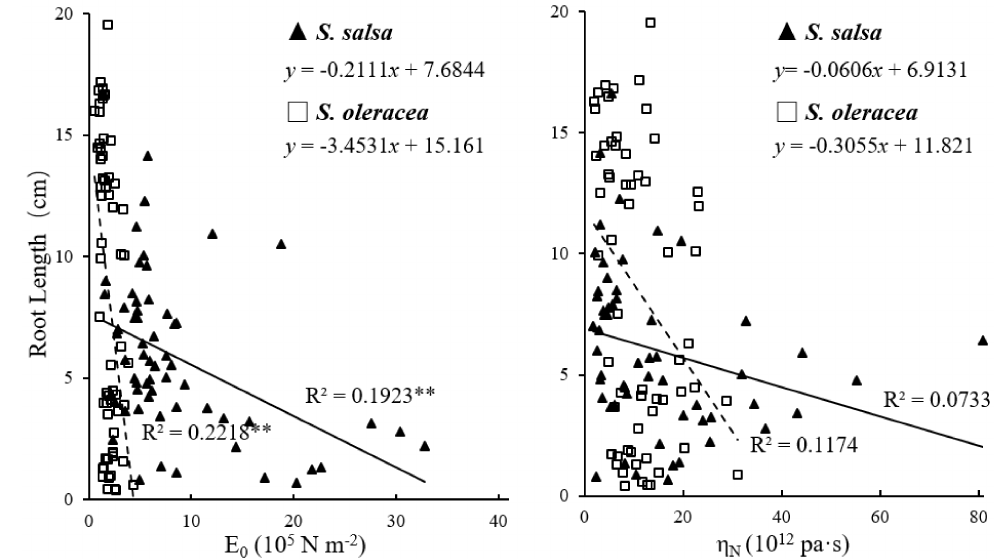
Figure 3. Correlation of root length with E 0 (elastic modulus; left panel) and η N (viscosity coefficient; right panel) in S. salsa (—) and S. oleracea (- - -) under 0, 100, 200, and 300 mM NaCl treatments. ** significant at p < 0.01 ( n = 56–60).